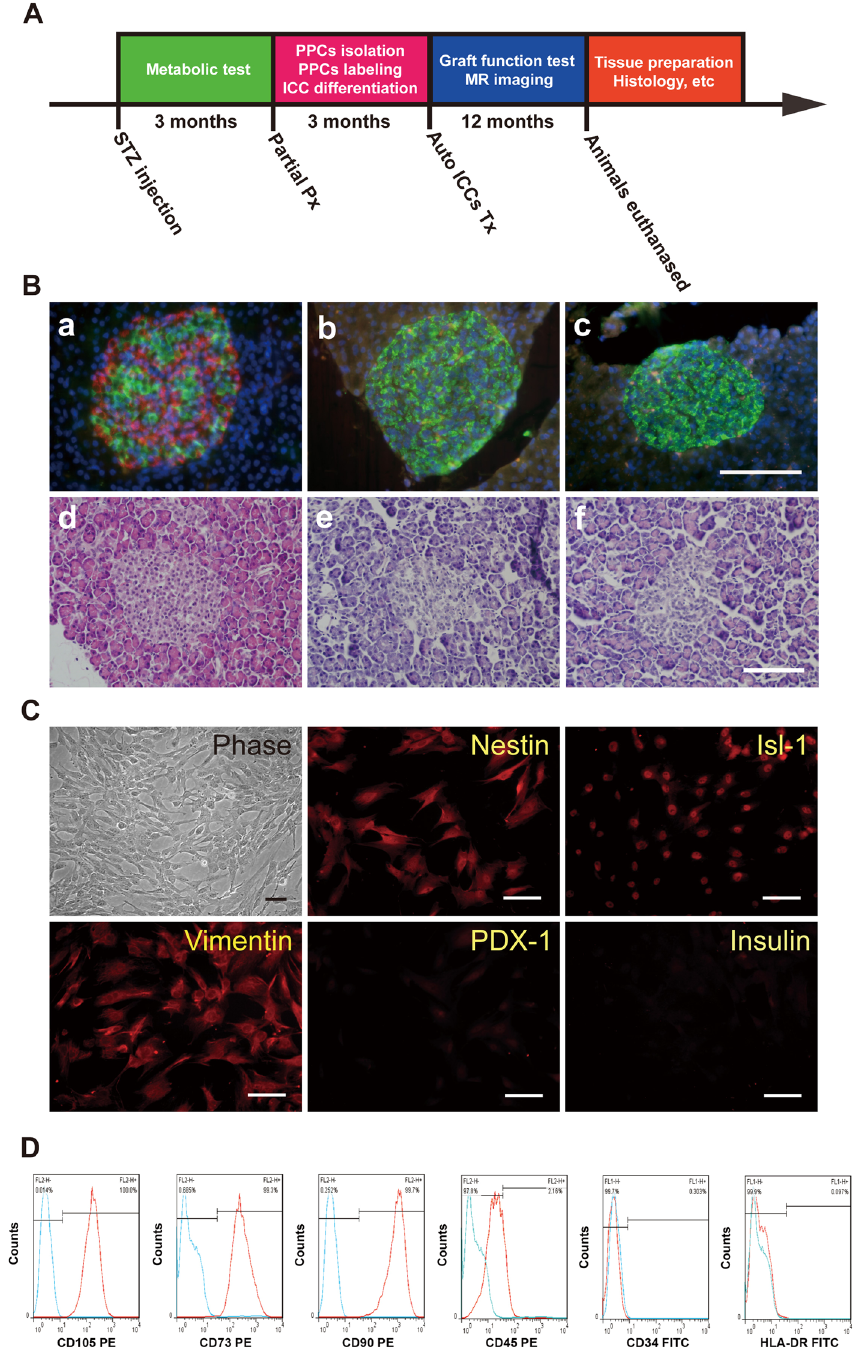
Figure 1. ( A ) A schematic diagram illustrating the experimental paradigm. ( B ) Immunostaining and H&E staining of pancreatic biopsies from normal monkeys (a, d), diabetic monkeys 3 months after STZ injection (b, e) and diabetic monkeys up to one year after implantation (c, f). In diabetic monkeys, insulin expression (red fluorescence) decreased, whereas glucagon expression (green fluorescence) appeared to have expanded. H&E staining showed that exocrine pancreatic cells in diabetic monkeys appeared histologically normal. ( C ) After 8 passages, the PSCs maintained classic MSC-like morphology, and immunofluorescence labeling showed that the PPCs were positive for nestin, Isl-1 and vimentin but negative for PDX-1 and insulin. ( D ) The PPCs exhibited a cell surface marker expression pattern similar to that of bone marrow-derived MSCs. Flow cytometry analysis showed that the PPCs were positive for CD105, CD73, and CD90 but negative for CD45, CD34, and HLA-DR. Scale bars represent 100 μ